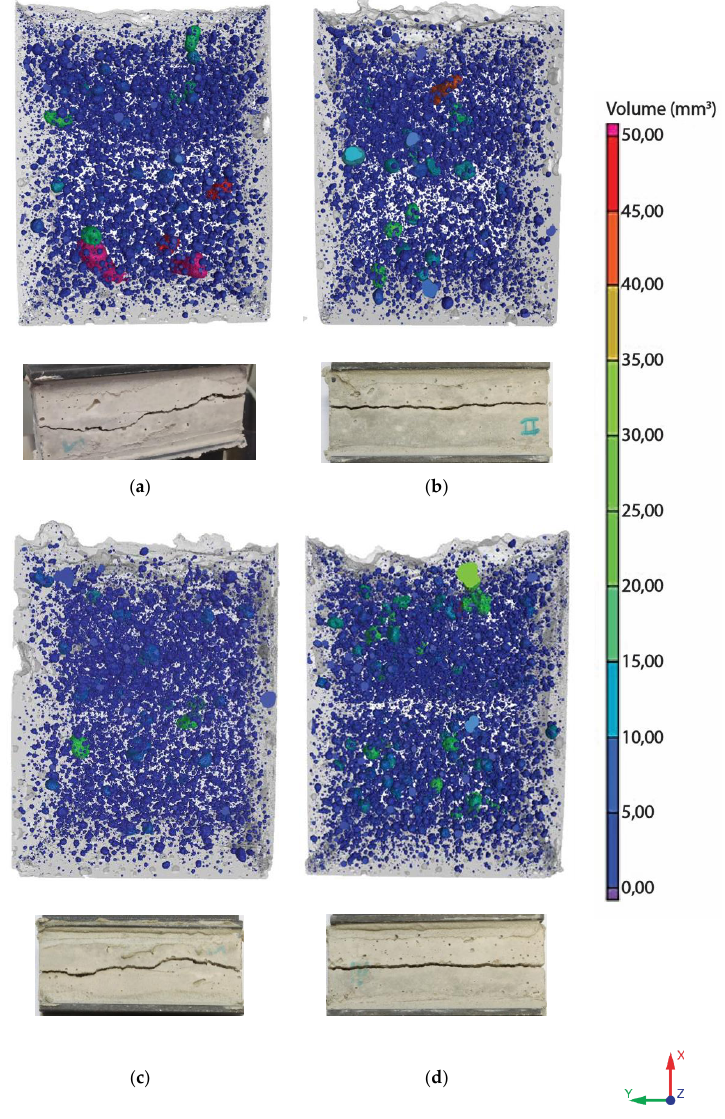
Figure 12. Comparison of the pore distribution and sizes for different entrapping times, illustrating the common crack patterns of the specimens. The computed tomography (CT) porosity of the specimens at di ff erent layering times, where the parameters are detailed in Table 2: ( a ) specimen T5, ( b ) specimen T10, ( c ) specimen T15, and ( d ) specimen